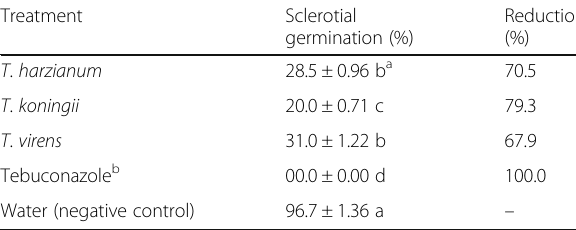
Table 2 Sclerotial germination (%) of S . cepivora isolate (Sc8) after soaking in cultural filtrates of Trichoderma strains as well as chemical fungicide in